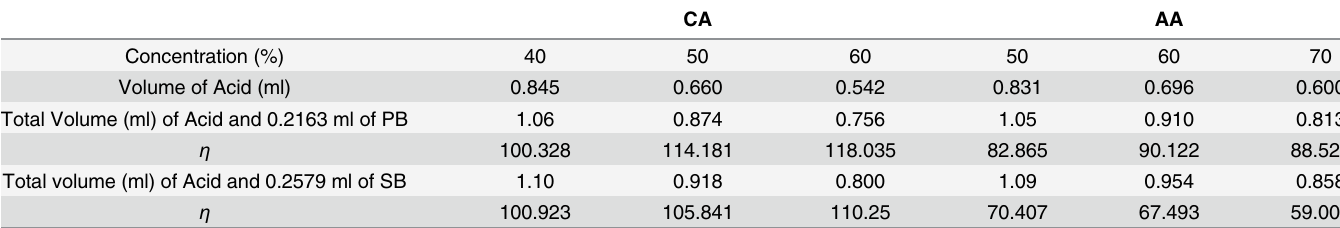
Table 1. Experimental results for different combinations of biocompatible acids and bases.